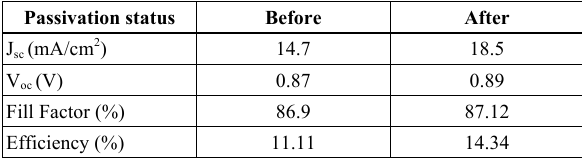
Figure 6. Current density versus voltage characteristics of a-Si solar cell after adding sidewall passivation. TABLE II. P HOTOVOLTAIC CHARACTERISTIC OF THE AMORPHOUS SILICON SOLAR CELL BEFORE AND AFTER SIDEWALL